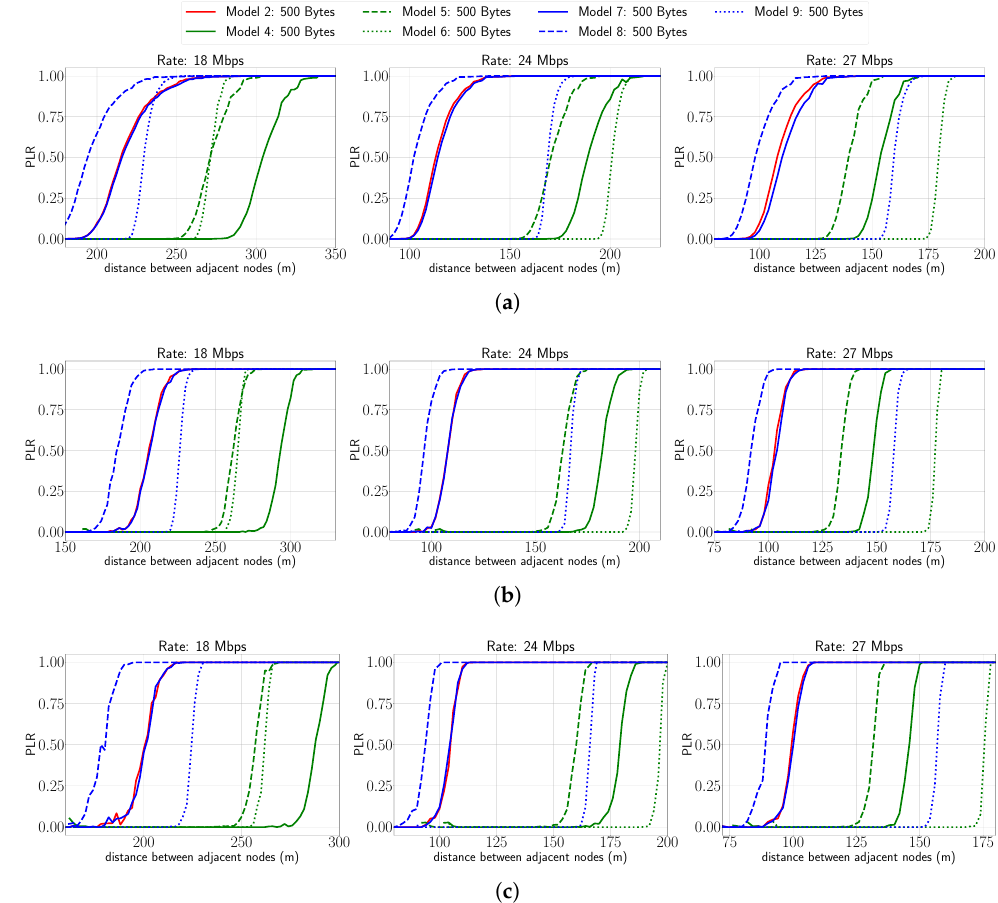
Figure 8. PLR vs. distance for different rates and for different linear chain topologies. Approximation of theoretical models with packet size of 500 bytes. ( a ) Number of nodes: 2, ( b ) number of nodes: 3, ( c ) number of nodes: